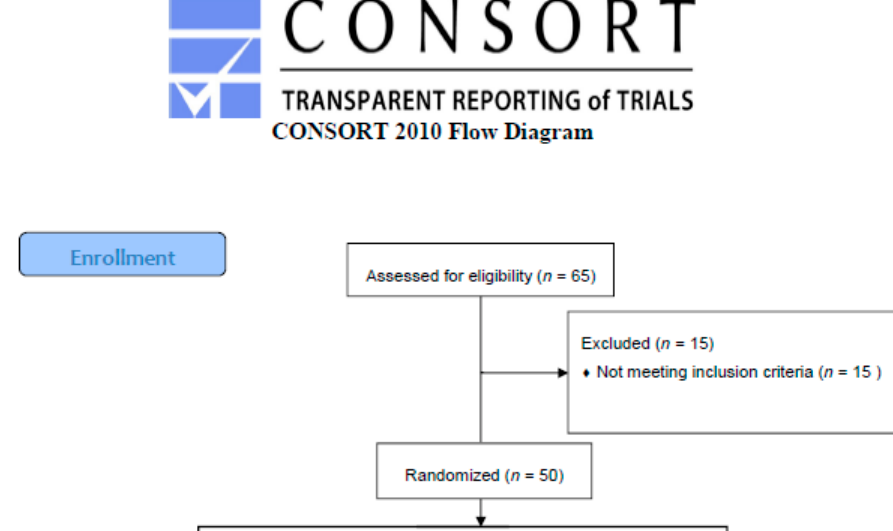
Figure S1: SCL-90 global index, Figure S2: SF-36 score for general health, Figure S3: VAS score for abdominal pain, Figure S4: VAS score for fecal consistency, Figure S5: VAS score for postprandial fullness severity.